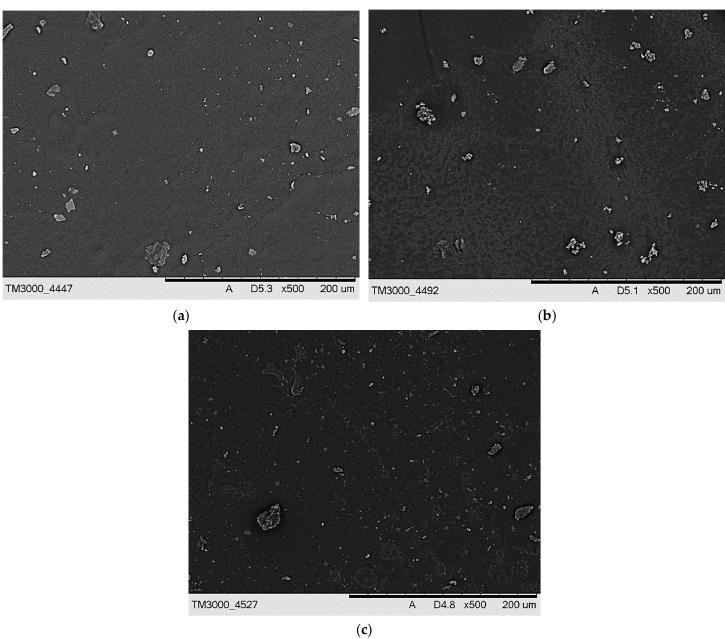
Figure 9. SEM image of sample 575/7.5 ( a ), 575/10.0 ( b ), and 575/12.5 ( c ). On the SEM images, any significant differences between the surface morphology of tested hydrogels were not observed. Additionally, any corrugation of the hydrogels’ surface that might be expected as a result of the use of various amount of the crosslinker was also not found. This is probably due to the modification of the hydrogel matrix with Aloe vera juice and vitamin C. Probably, the surface morphology analysis of hydrogels after the incubation studies would allow to observe larger differences in the microstructure of the material. Nonetheless, it should be noticed that the results of SEM analysis are consistent with the results of hydrogels’ imaging via the KEYENCE digital microscope.